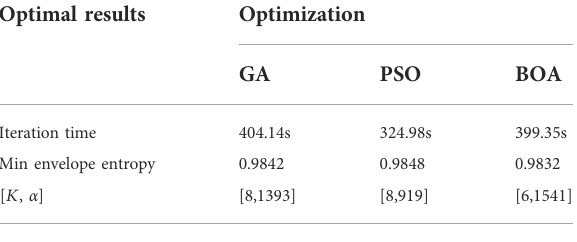
TABLE 1 Optimization results of three types of optimization algorithms. Optimal